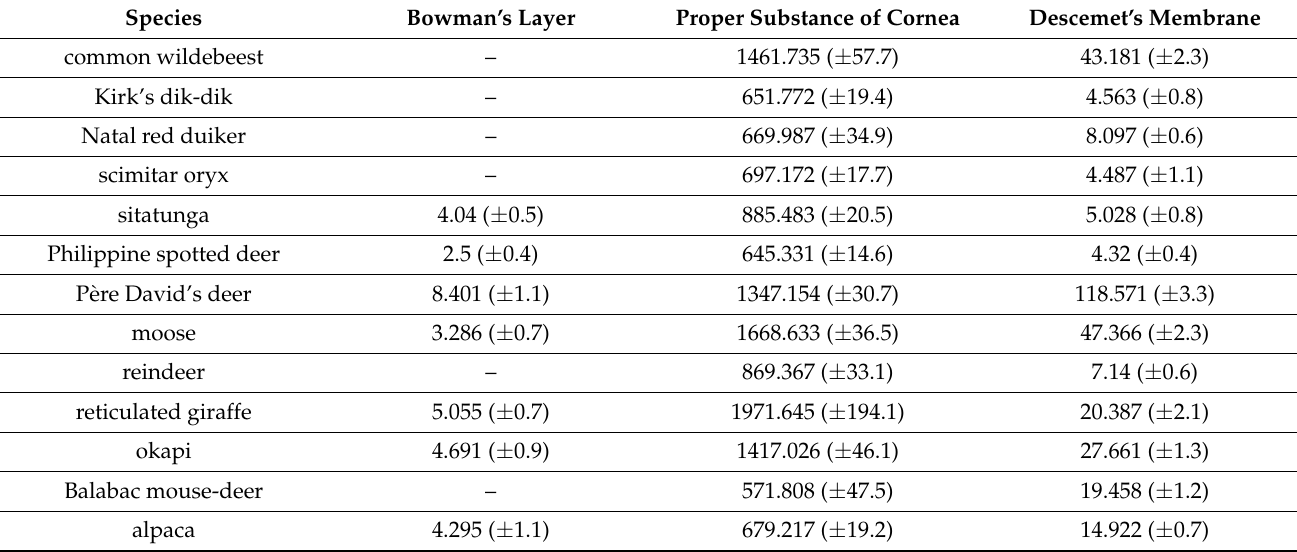
Table 3. Thickness ( µ m) of the Bowman’s layer, the proper substance of the cornea and Descemet’s membrane in the examined